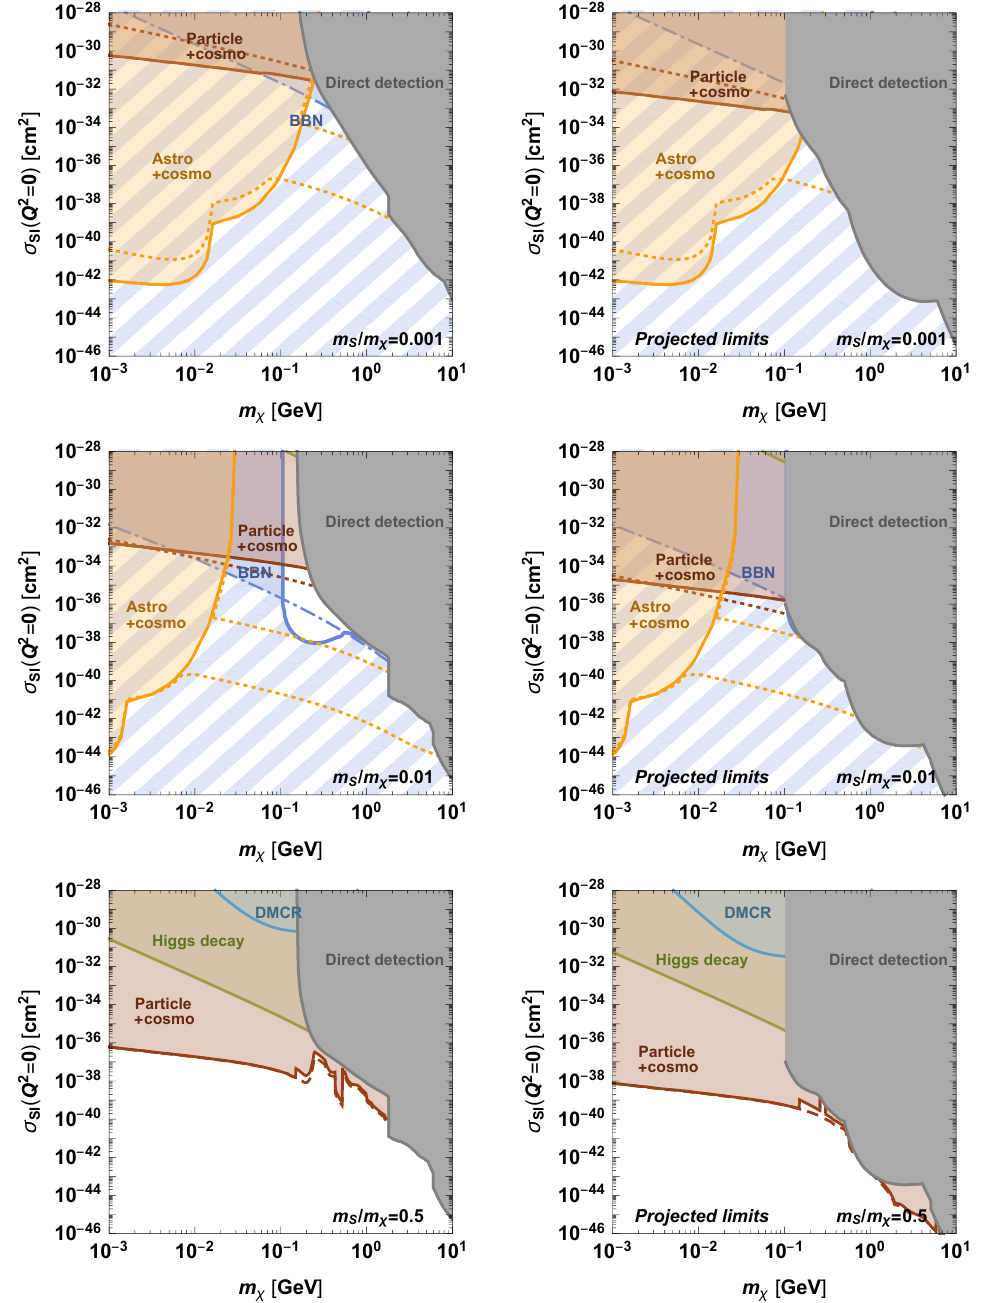
Figure 5 . Current (left) and projected (right) limits on the elastic scattering cross section with nucleons in the zero-momentum transfer limit, for (cid:12)xed scalar to DM mass ratios m S =m (cid:31) that do not allow invisible decays of S . For astrophysical and particle physics limits combined with cosmological limits, dotted lines assume thermal DM production via freeze-out (‘Cosmo 1’), dashed lines instead implement generic DM self-interaction constraints (‘Cosmo 2’) while solid lines result from tuning g (cid:31) such as to resonantly suppress the DM self-scattering rate (‘Cosmo 3’). See text for further details.